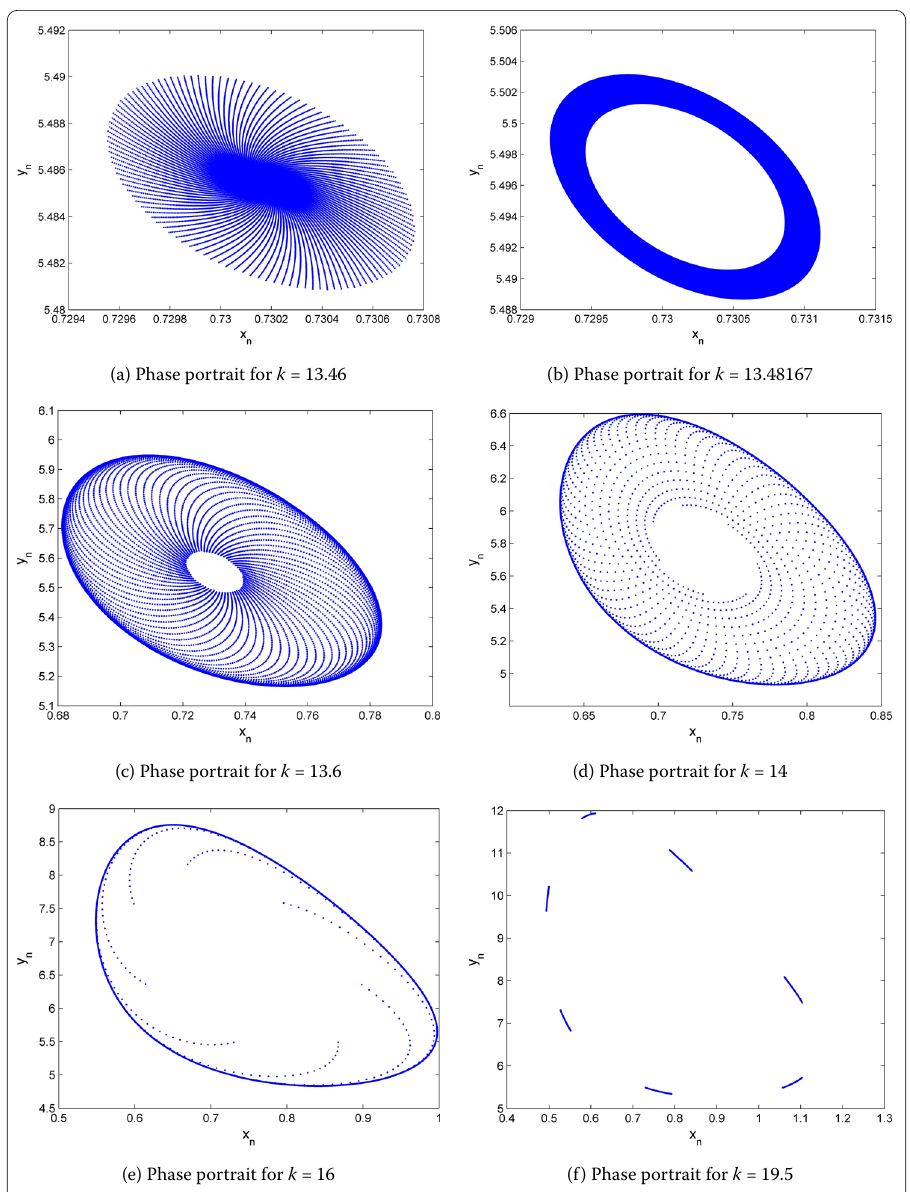
Figure 9 Phase portraits of system (1.3) for p = 7.3, q = 4.6, x 0 = 0.73, y 0 = 5.49 with different values of